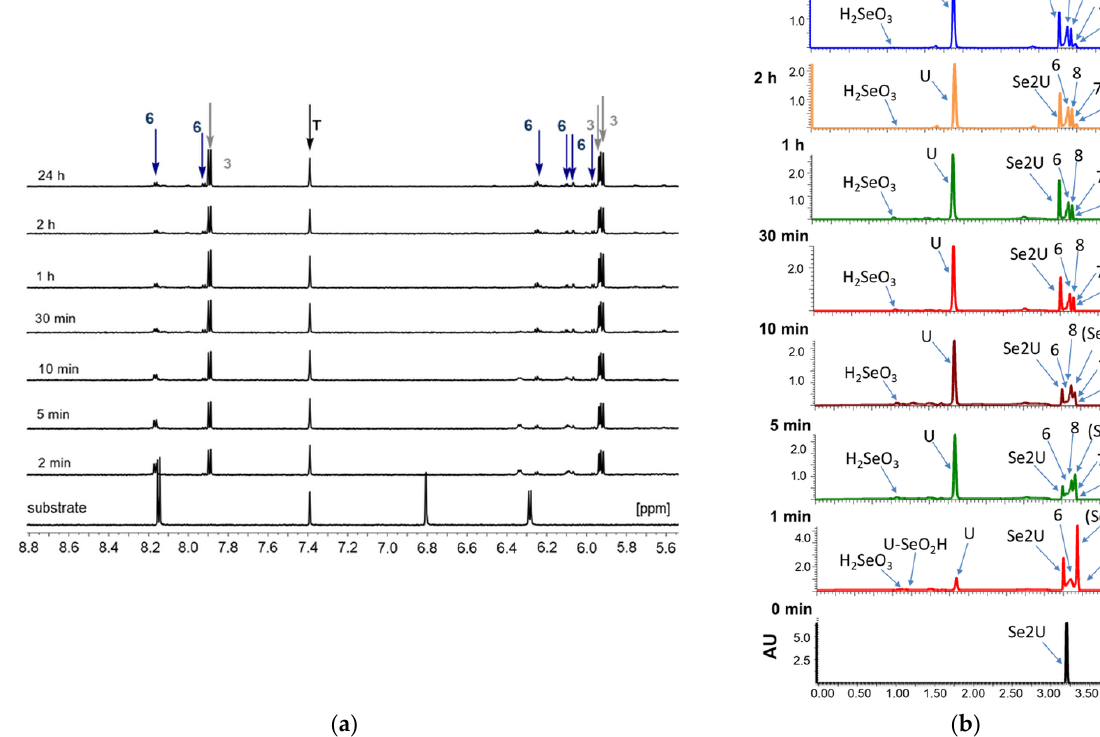
Figure 2. ( a ) 1 H NMR analysis of the reaction mixtures for the oxidation of Se2U ( 1 , 10 mM) with H 2 O 2 (10 mM) in 67 mM phosphate buffer at pH 7.4 and room temperature at the indicated time point. The chemical shifts ( δ , ppm) for protons H5, H6, and H1 ′ , as well as the coupling constants J H6-H5 and J H1 ′ -H2 ′ , as well as the m / z values for all identified compounds are given in Table 2. A total of 5 mM thymine was used as an internal standard; ( b ) UPLC–PDA chromatographic analysis of the time course of products formation for the oxidation reaction of Se2U ( 1 , 10 mM) with H 2 O 2 (10 mM) in 67 mM phosphate buffer at pH 7.4 and rt. The m / z values are given in Table 2. The inorganic selenous acid was identified by UPLC-ESI(-)-HRMS, and its retention time was determined based on the extracted ion chromatograms (EICs) for the ion corresponding to the deprotonated molecule ( m / z 128.909). Table 2. UPLC–PDA–ESI(-)-HRMS and 1 H NMR data of 1 and organic products 2 – 8 of the oxidation reaction of Se2U with H 2 O 2 . For all identified compounds, the UPLC retention time (Rt, min) and m / z data (atomic mass unit to its formal charge ratio) for [M-H] - in negative mode, the maximum wavelength λ max in UV/VIS spectra (nm) and 1 H NMR chemical shifts (ppm) of H5 and H6 protons and their coupling constant J H 6 H 5 is given.